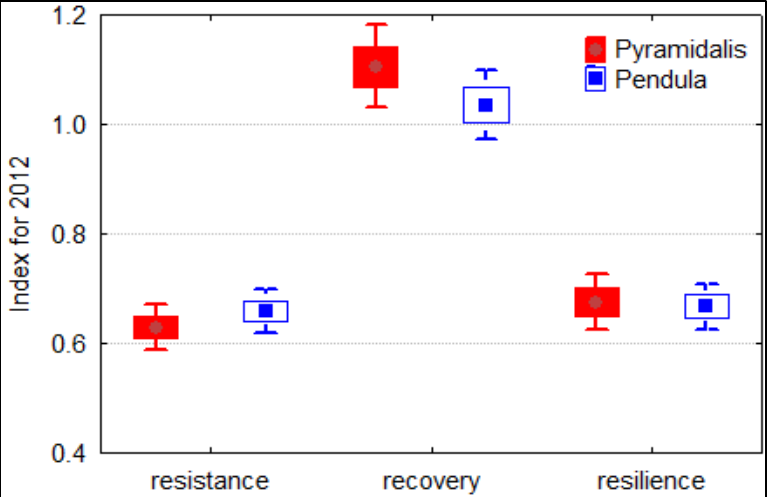
Figure 5. Boxplot showing the mean values and errors bars for resistance, recovery, and resilience indices of individual ring width series of the two Norway spruce forms.